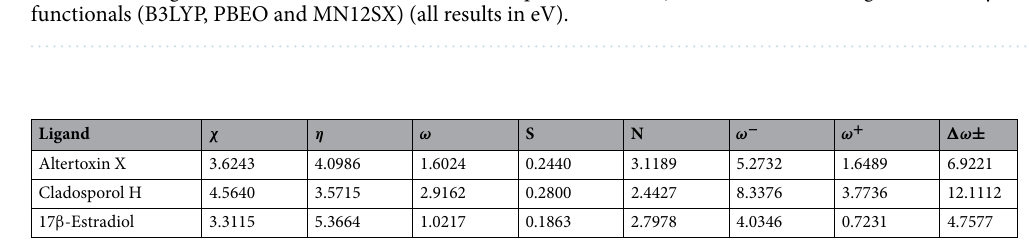
Table 6. Global reactivity descriptors or Altertoxin X, Cladosporol H, and 17 β -estradiol considering the MN12SX/Def2TZVP/H2O model chemistry. Note: χ - Electronegativity; η - Global Hardness; ω - Electrophilicity; S - Global Softness; N - Nucleophilicity; ω − - Electrodonating Power; ω + - Electroaccepting Power; �ω ± - Net Electrophilicity. All the descriptors are expressed in eV, with the exception of S, which is expressed in eV − 1